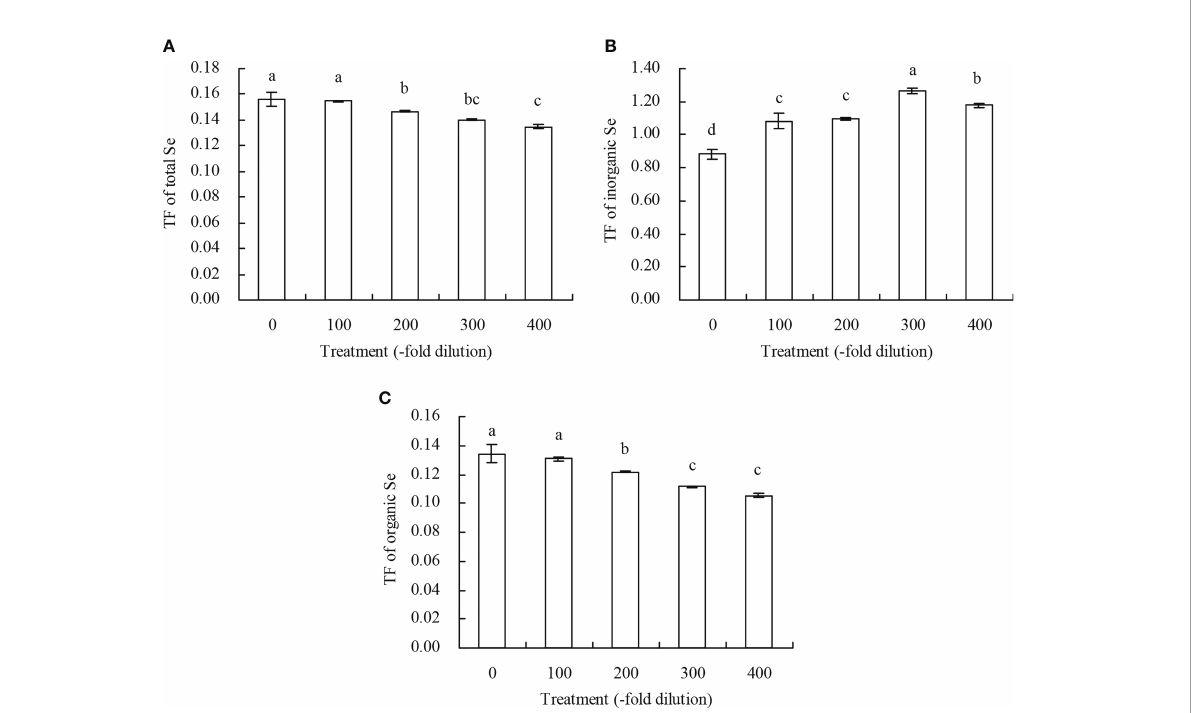
FIGURE 6 TF of Se of peach seedlings. (A) : TF of total Se; (B) : TF of inorganic Se; (C) : TF of organic Se. Values are means ± SD of three replicates. Different lowercase letters indicate signi fi cant differences among the treatments (Duncan ’ s Multiple Range Test, P < 0.05). Translocation factor (TF) = Se content in shoots/Se content in roots.